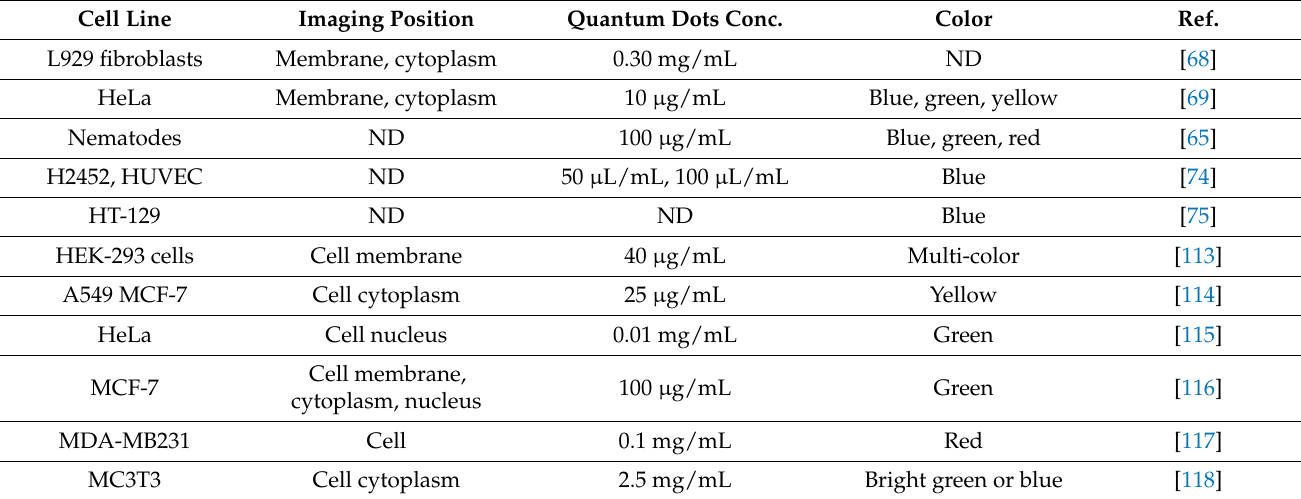
Table 2. Recent bioimaging application of CQDs and GQDs. Quantum Dots Conc. Color